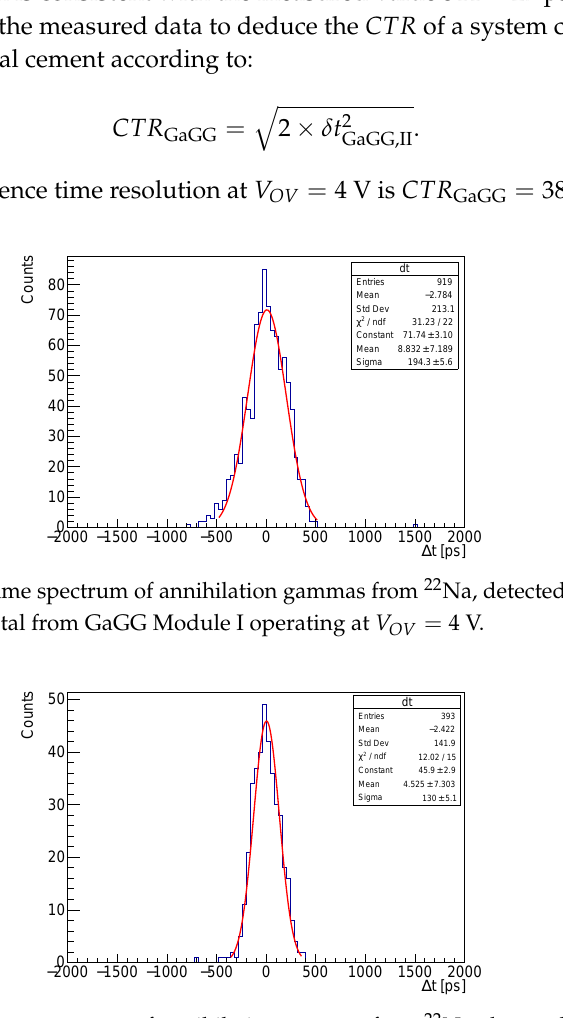
Figure 6. Coincidence time spectrum of annihilation gammas from 22 Na, detected by a 3 × 3 × 3 mm 3 LYSO crystal and a crystal from GaGG Module II operating at V OV = 4 V.